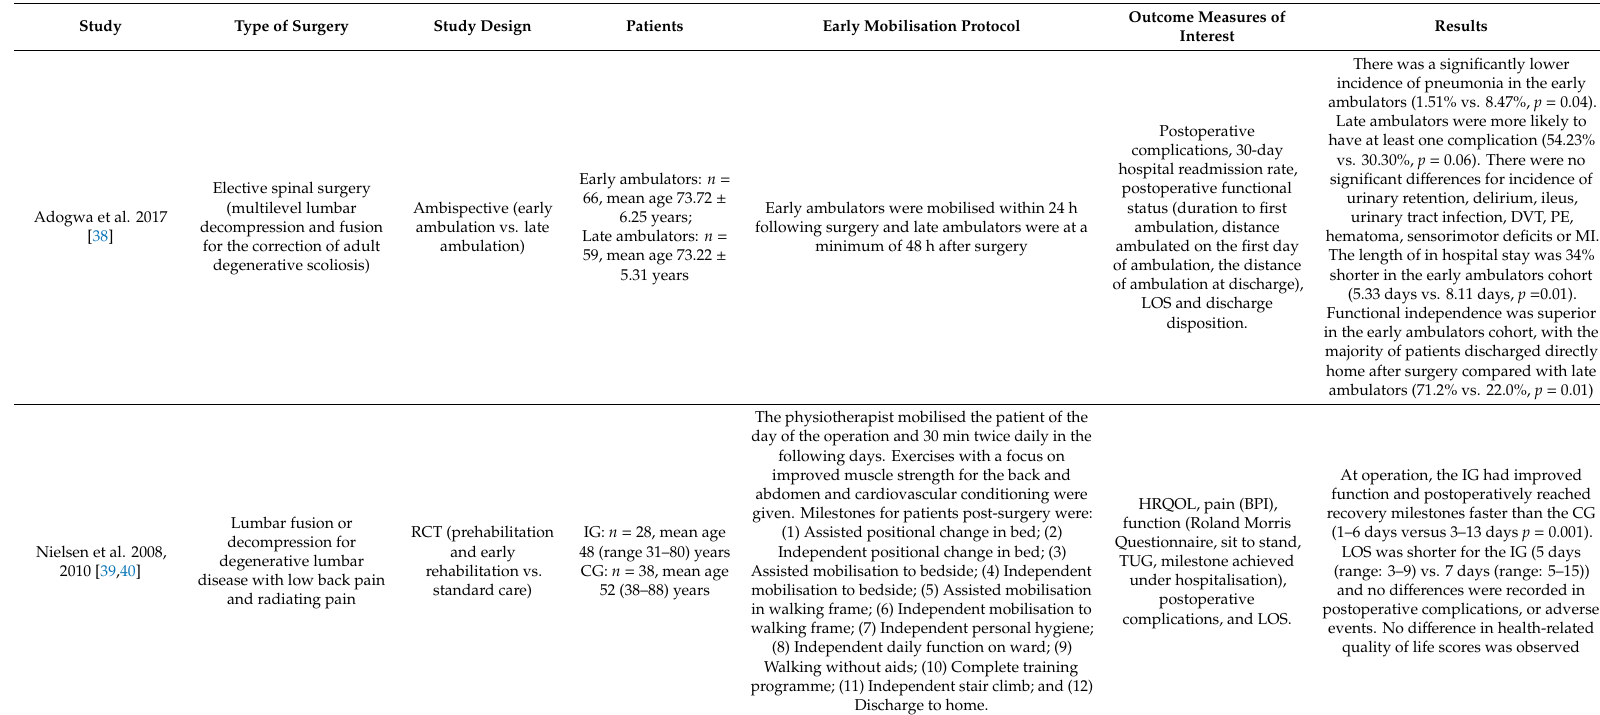
Table 2. Summary of studies (early mobilisation intervention